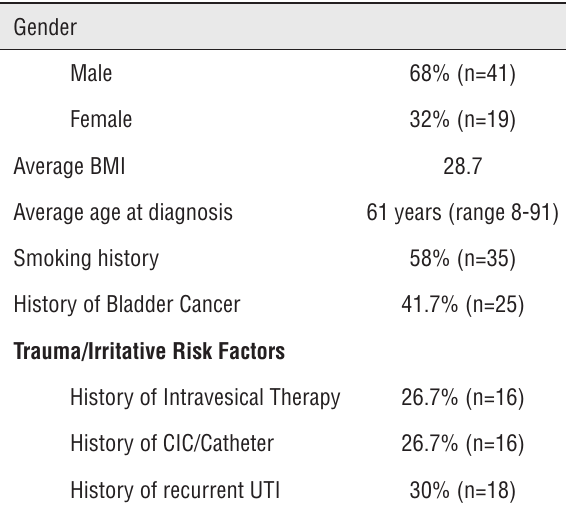
Table 1 - patient characteristics.